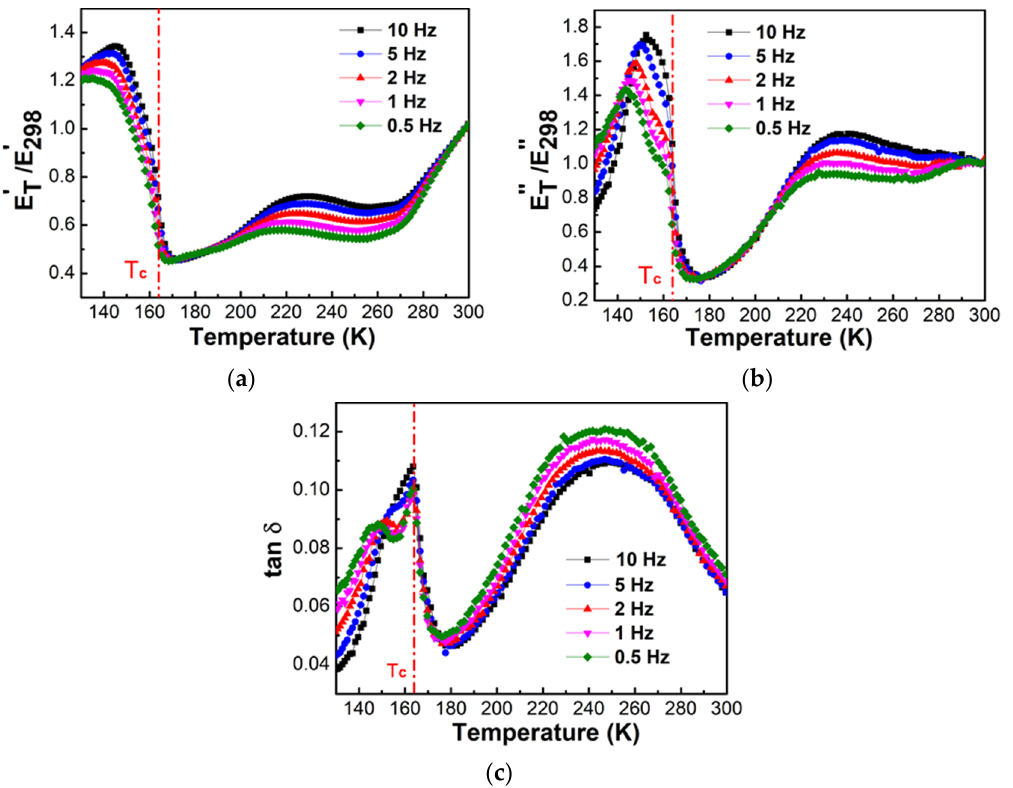
Figure 7. Temperature dependences of ( a ) the normalized storage modulus, E’ T /E’ 298 , ( b ) the normalized loss modulus, E’’ T /E’’ 298 , and ( c ) loss factor tan δ of [(CH 3 ) 2 NH 2 ][Fe(HCOO) 3 ] pellets at frequencies of 0.5–10 Hz determined by DMA during heating at the rate of 2 K/min. The vertical dash-dotted line indicates the ferroelectric transition temperature T c ~ 164 K.